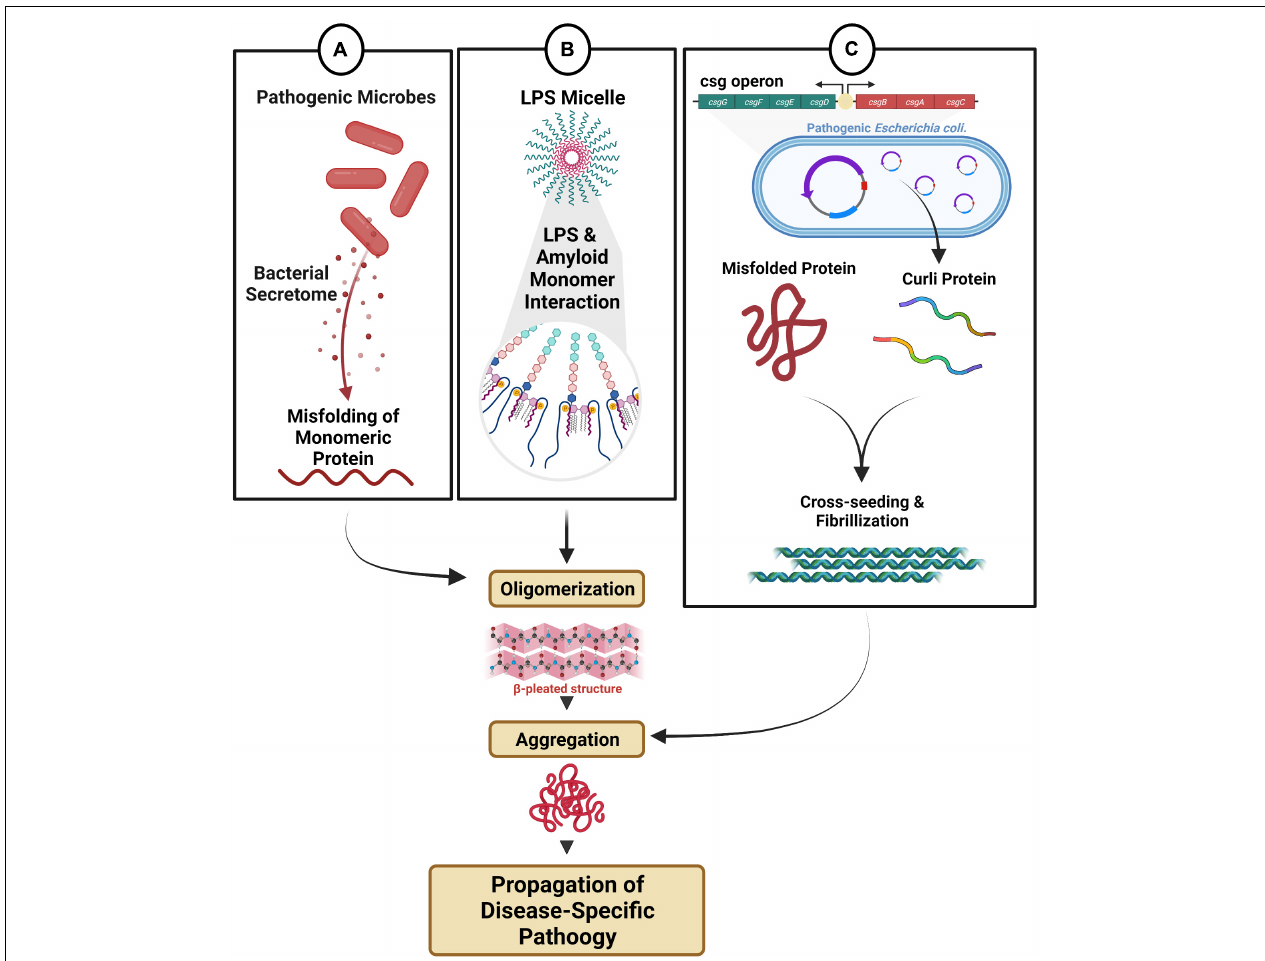
FIGURE 2 | Microbial dysbiosis-mediated fibril formation. (A) Distinct microbes secrete metabolites that can directly and/or indirectly modulate fibril formation. (B) Endotoxin and LPS micelles can interact with amyloid monomeric protein triggering oligomerization and aggregation. (C) Pathogenic bacteria with csgA/B operon produce amyloid curli proteins, which can participate in cross-seeding, fibrillization and aggregation.